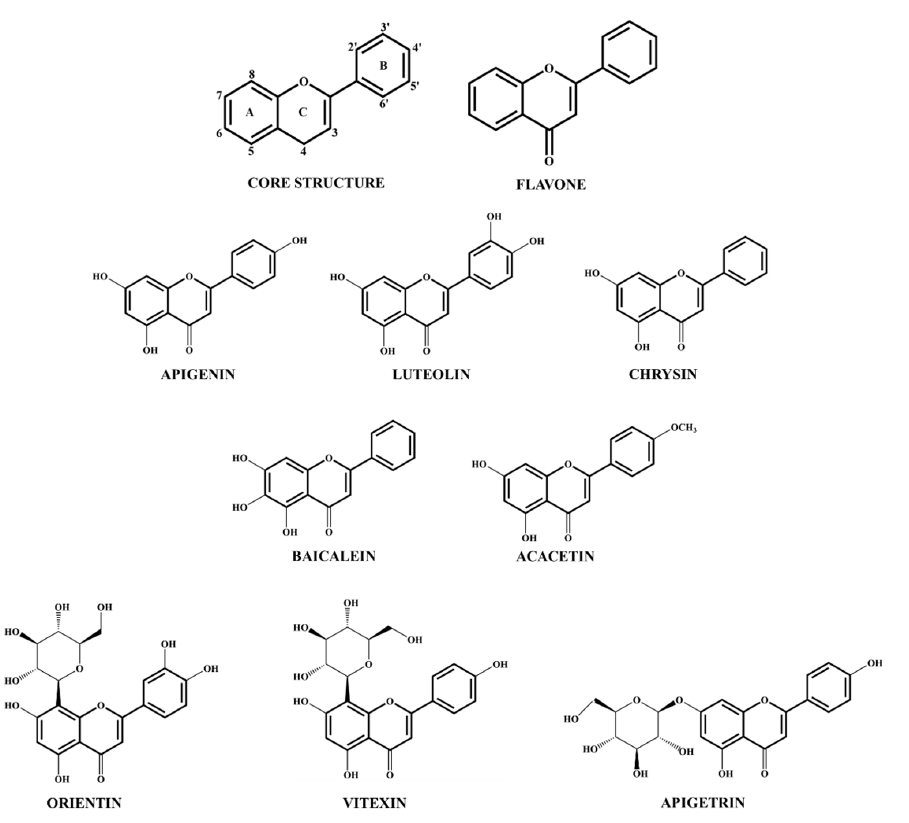
Figure 3. Structure of flavonoid core and different flavones.